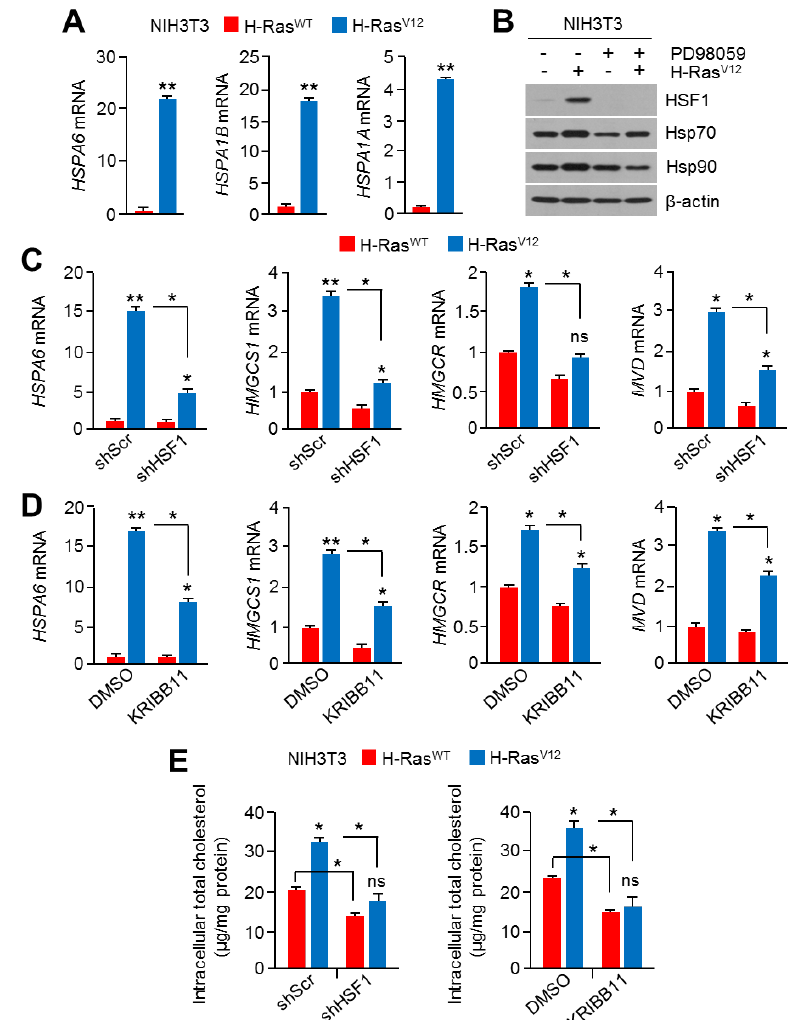
Figure 5. HSF1 was involved in the activation of the mevalonate and cholesterol biosynthesis pathway through RAS-MAPK signaling. ( A ) Heat shock responsive genes were measured in H-Ras V12 -overexpressing NIH3T3 cells. The values represent the mean ± SD of two independent experiments performed in triplicate. ( B ) H-Ras WT - or H-Ras V12 -overexpressing NIH3T3 cells were cultured for 24 h in the absence or presence of PD98059 (10 µ M), and then protein levels were measured by western blotting. ( C ) H-Ras WT - or H-Ras V12 -expressing NIH3T3 cells were infected with short-hairpin RNA (shRNA)-targeting control or HSF1-encoding lentiviral particles, and then infected cells were further incubated for 48 h. The mRNA levels were measured using qRT-PCR. The values represent the mean ± SD of three independent experiments performed in duplicate. ( D ) H-Ras WT - or H-Ras V12 -expressing NIH3T3 cells were incubated for 24 h in the absence or presence of KRIBB11 (5 µ M), and then mRNA levels were measured. The values represent the mean ± SD of three independent experiments performed in duplicate. ( E ) H-Ras WT - or H-Ras V12 -overexpressing NIH3T3 cells were cultured for 24 h in a DL-FBS condition in the absence or presence of HSF1 knocking-down shRNA or KRIBB11 (5 µ M), and then cells were used to measure intracellular cholesterol levels. The values represent the mean ± SD of three independent experiments performed in duplicate. * p < 0.05; ** p < 0.01; ns, not